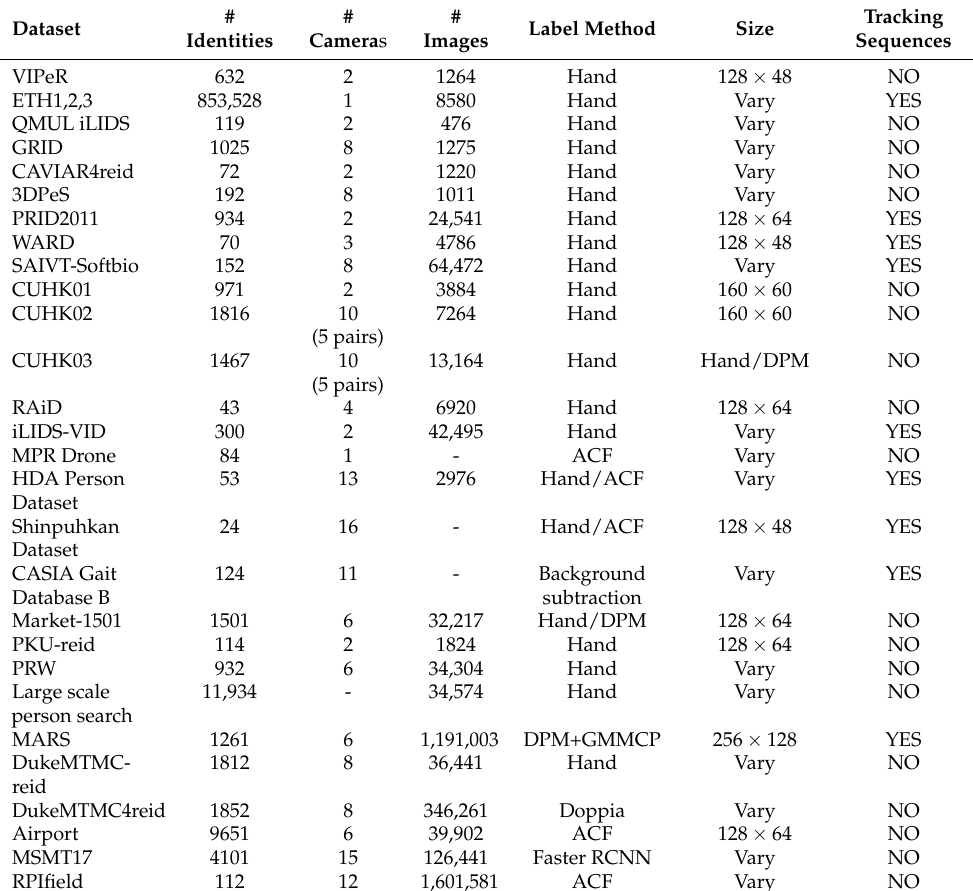
Table 1. Global overview of the found public available databases for person